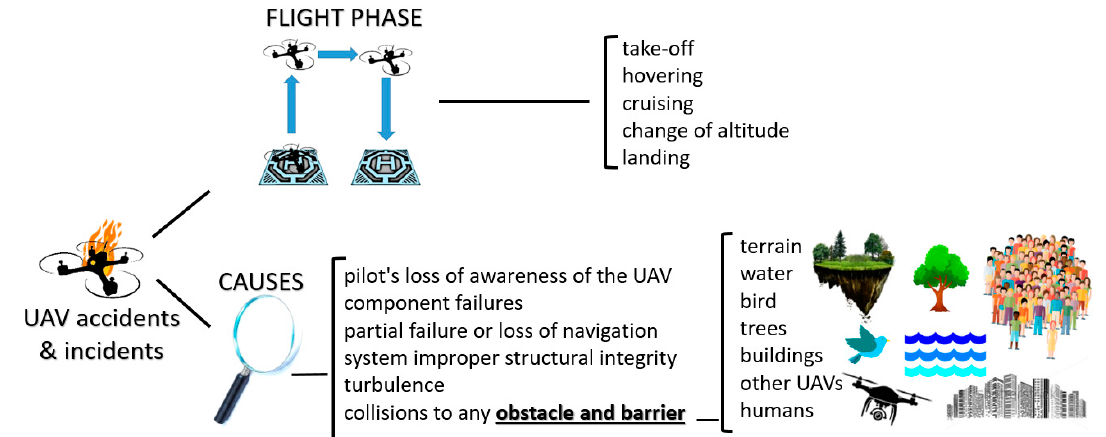
Figure 1. UAV accident and incident causes and flight phases.